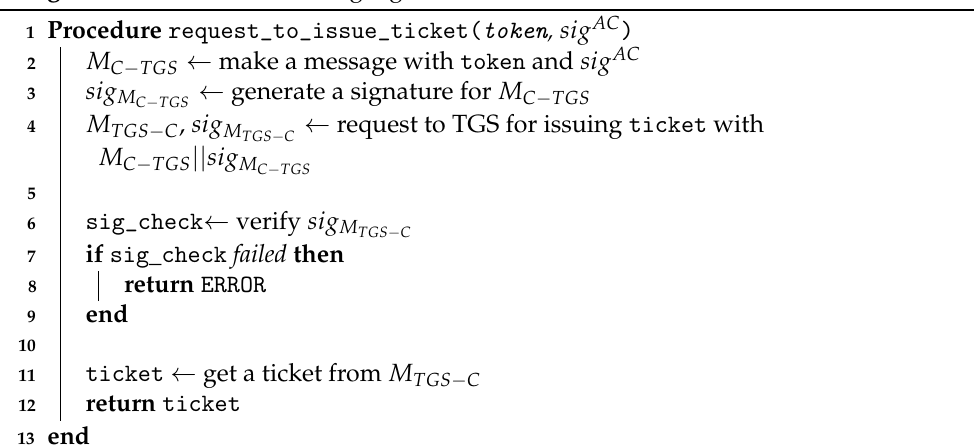
Algorithm 5: The ticket issuing algorithm on the user